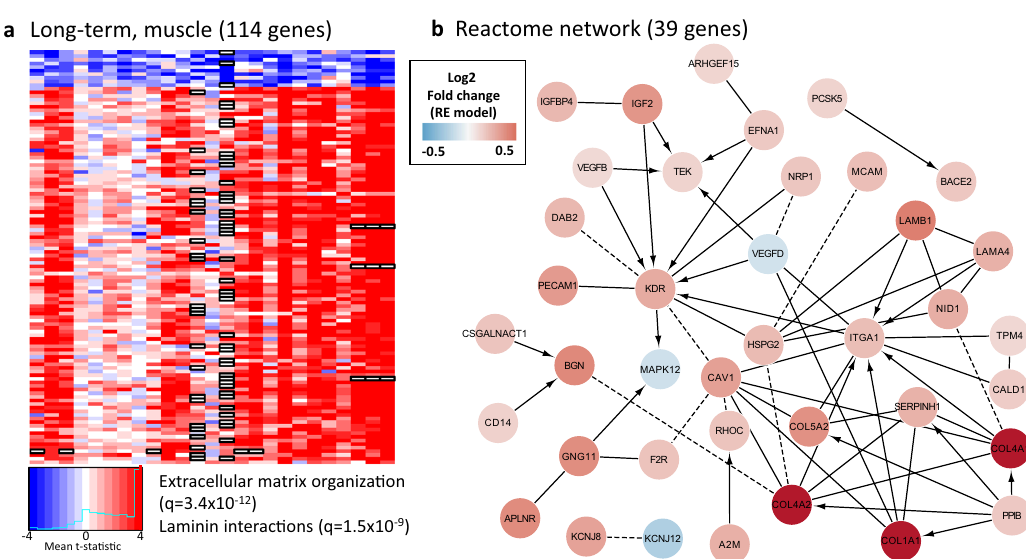
Fig. 5 Long-term training muscle response genes with moderator-independent patterns. a Heatmap of the ten downregulated and 104 upregulated genes b The main connected component linking most of the upregulated genes to known protein – protein interaction networks. Highlighted nodes are genes with known pathway interactions in Reactome. The laminin interactions Reactome pathway covers only a small part of the upregulated gene module. Dashed lines represent co-occurrence in a complex. Directed edges represent regulation. Source data are provided as a Source Data fi